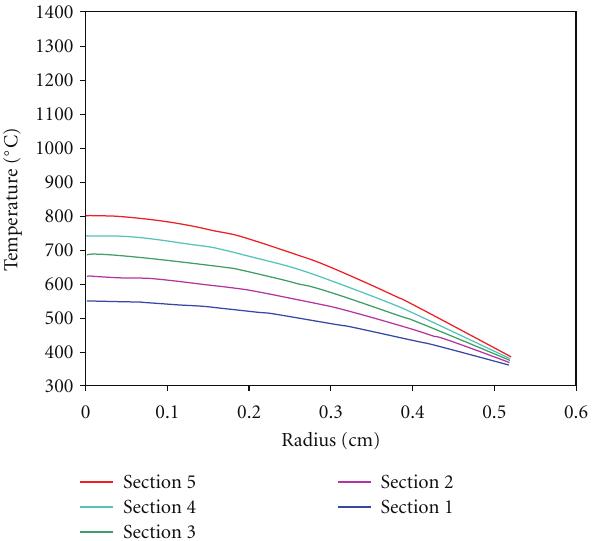
Figure 7: Pellet profile of five axial sections of the MOX fuel A.1.3 before ramping at EOL.